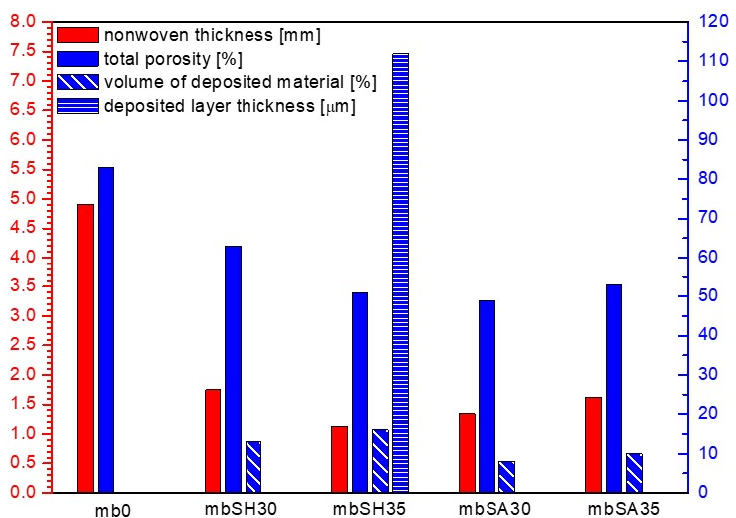
Figure 6. Structural parameters of unmodified and modified melt ‐ blown PLA nonwoven fabrics.